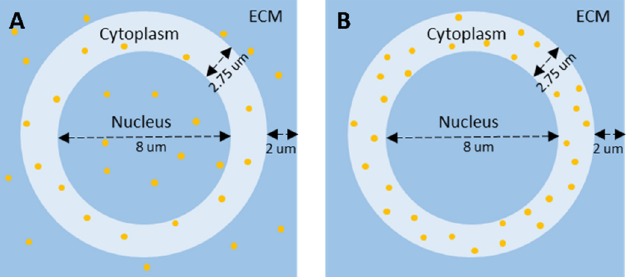
Figure 3. Schematic diagrams of cell with different AuNP biodistribution. ( A ) Homogenous cell model. ( B ) Cytoplasm cell model.